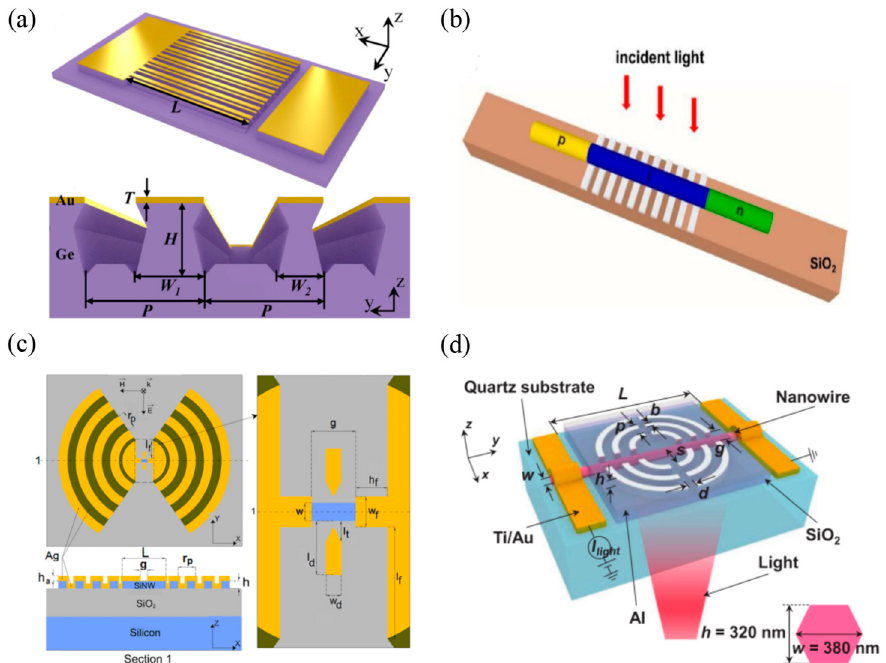
Figure 7. Structures and performance characterization of 1D materials-based infrared PDs with grating structures. ( a ) Schematic illustration of the dual-band plasmon-enhanced PD with alternate Au grating-Ge NW arrays [57]. Copyright 2021, Applied Physics Letters . ( b ) Schematic diagram of the laterally oriented NW solar cells with Ag gratings [58]. Copyright 2021, Nanomaterials . ( c ) Schematic diagram of the designed plasma antenna structure [59]. ( d ) Schematic of the InP NW PD fabricated with DSBE antenna [60]. Copyright 2020, Advanced Optical Materials.